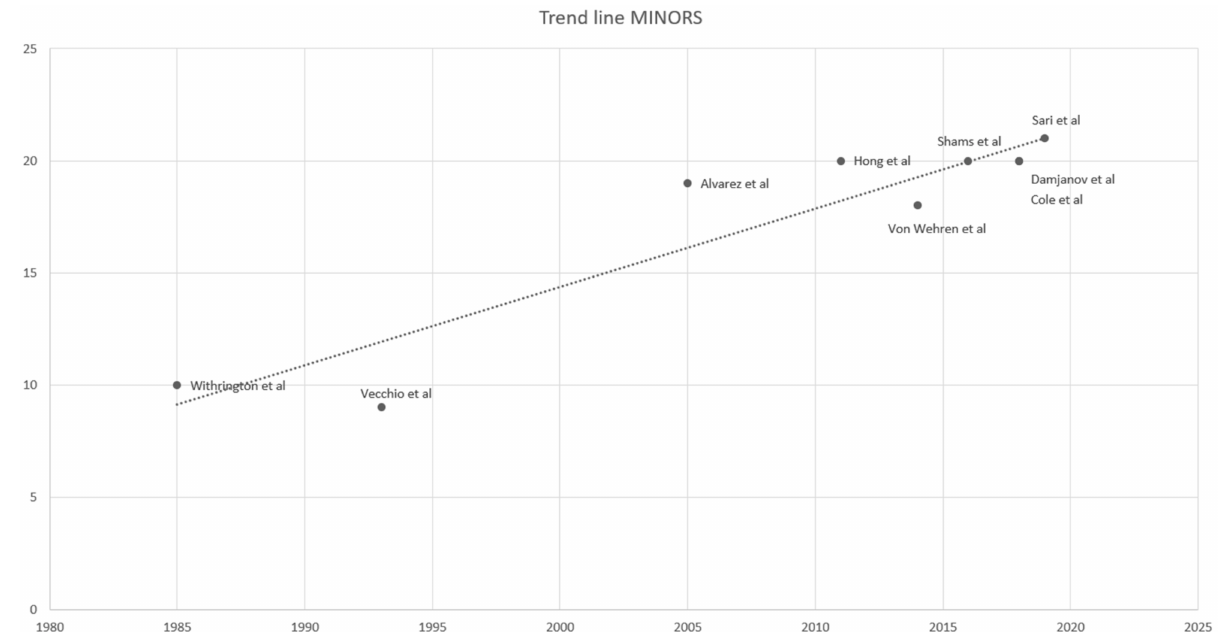
Figure 2. Trend line MINORS